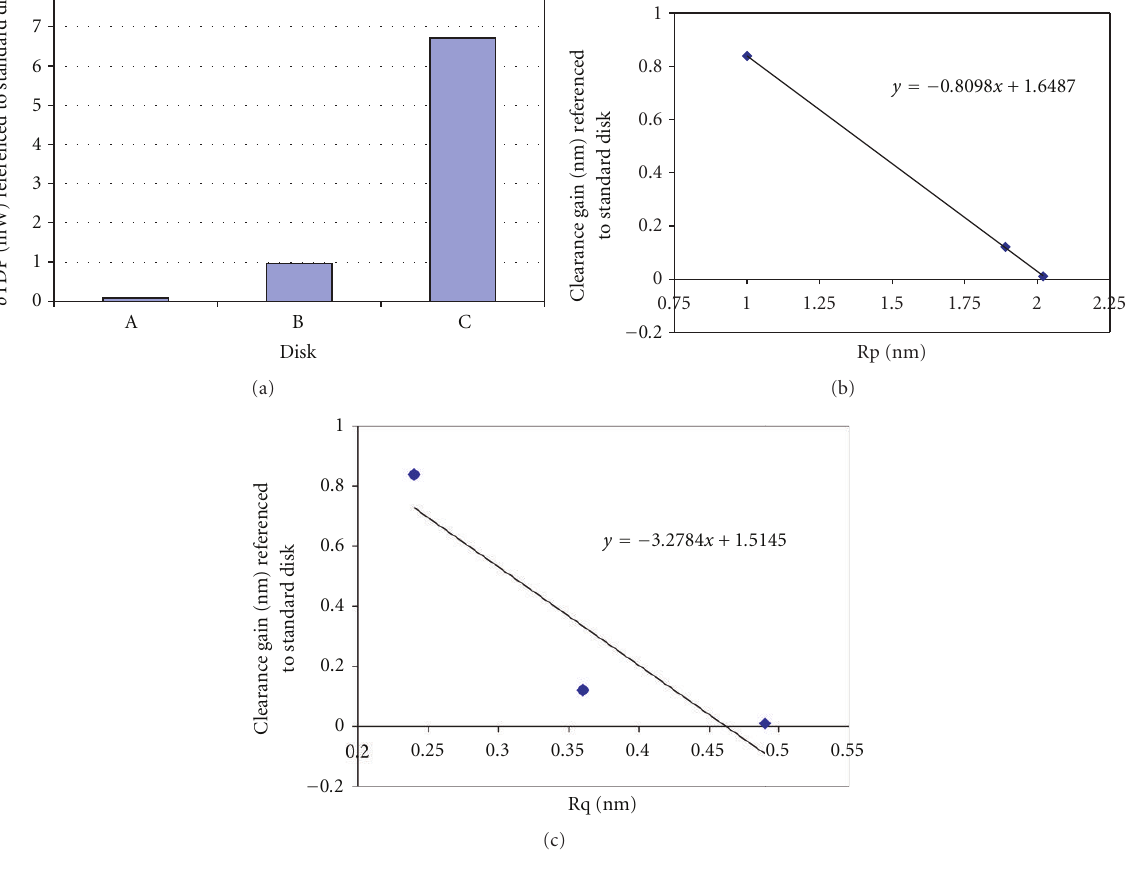
Figure 9: E ff ect of disk roughness on